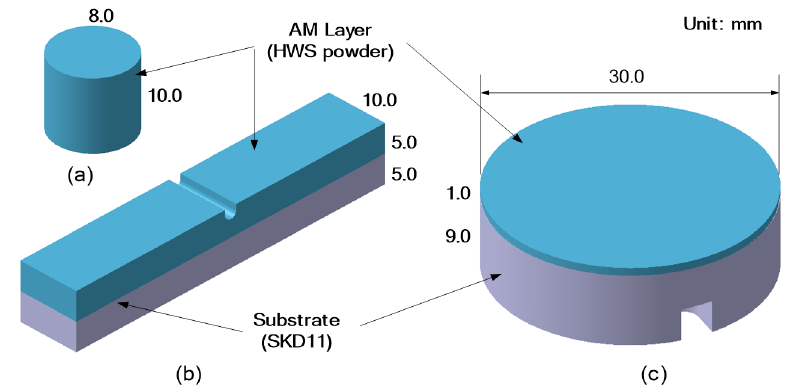
Figure 3. Specimen concept design for the evaluation of the properties of additive manufacturing (AM) material: ( a ) Design shape of the AM specimen for the compressive strength test and density measurement; ( b ) Design shape of the AM specimen for the impact absorption energy measurement; ( c ) Design shape of the AM specimens for the wear resistance and hardness tests.